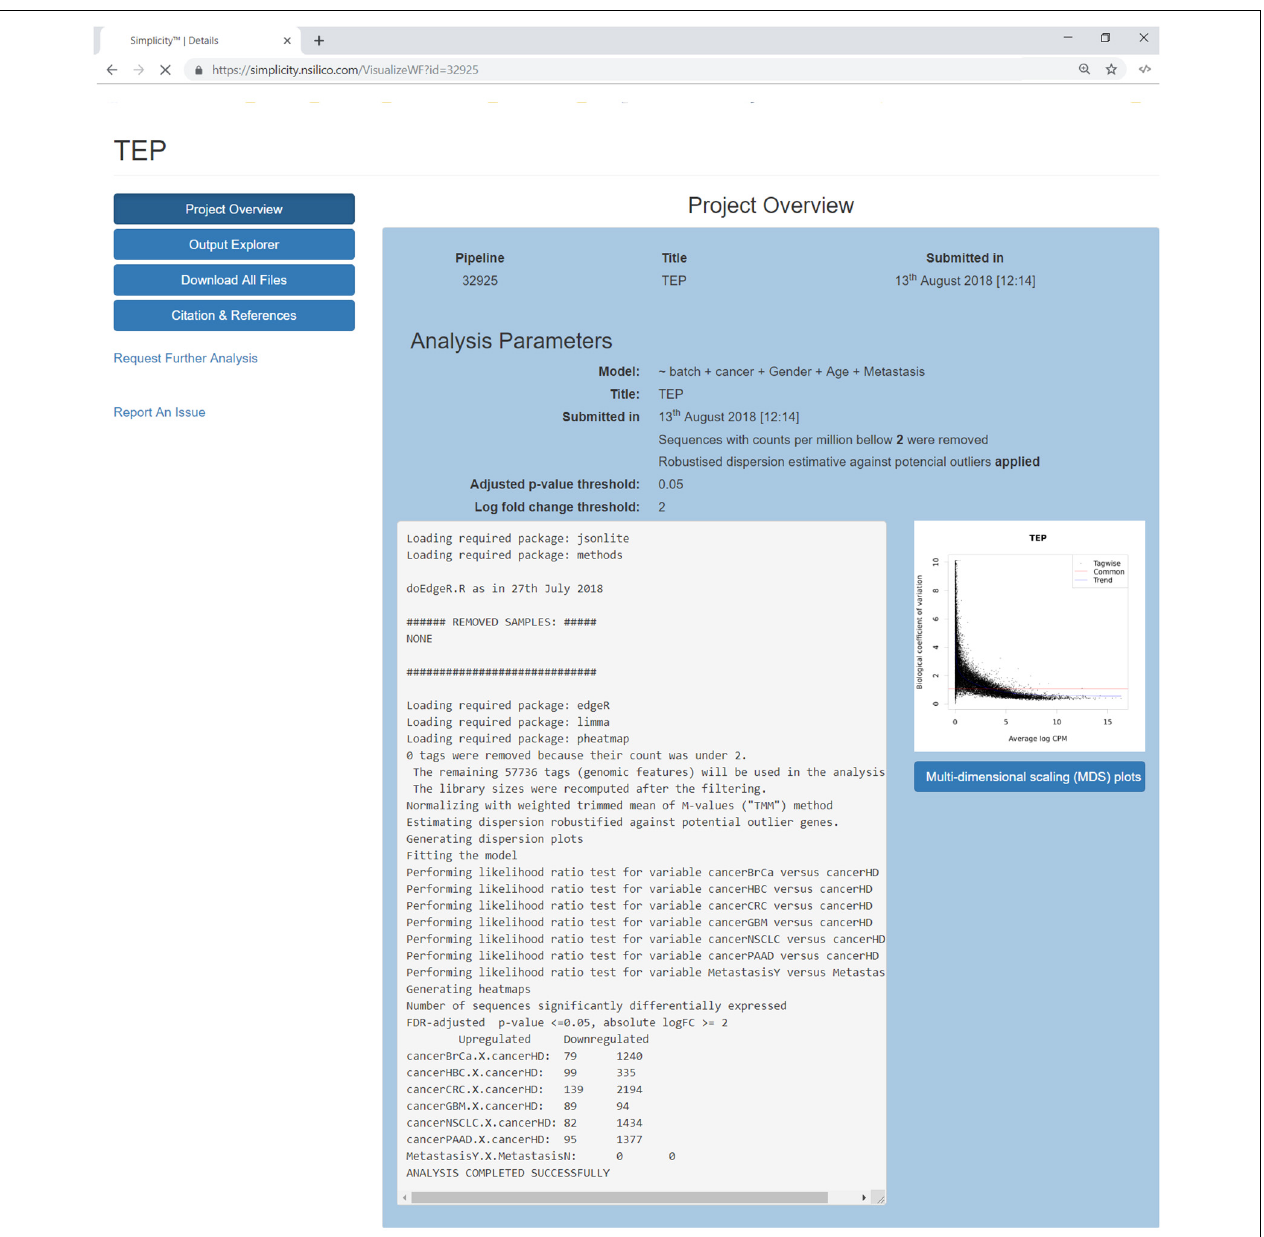
FIGURE 3 | Project’s results overview interface. The blue buttons on the top left allow the user to navigate through the results features, it is also possible to report issues or request further analysis. The main panel reviews the analysis settings and its log, which lists all the steps done during the pipeline run and generates a summary of the genes found up and down-regulated. On the right, a dispersion plot showing the data distribution based on the biological coefficient of variation log CPM average. The biological coefficient of variation represents the coefficient of variation that would remain between biological replicates if sequencing depth could be increased indefinitely. Finally, the user can explore the generated multidimensional scaling plot clicking on the button on the